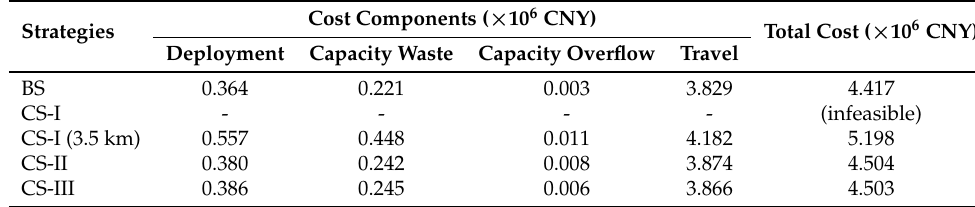
Table 4. Optimal results of various site deployment strategies.